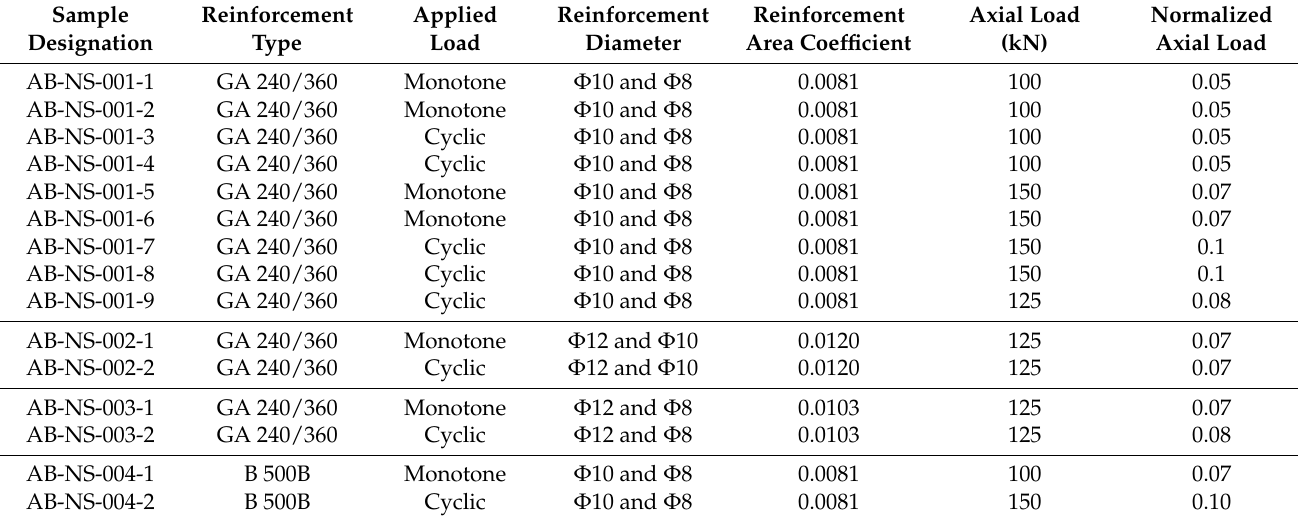
Table 1. Column specimens’